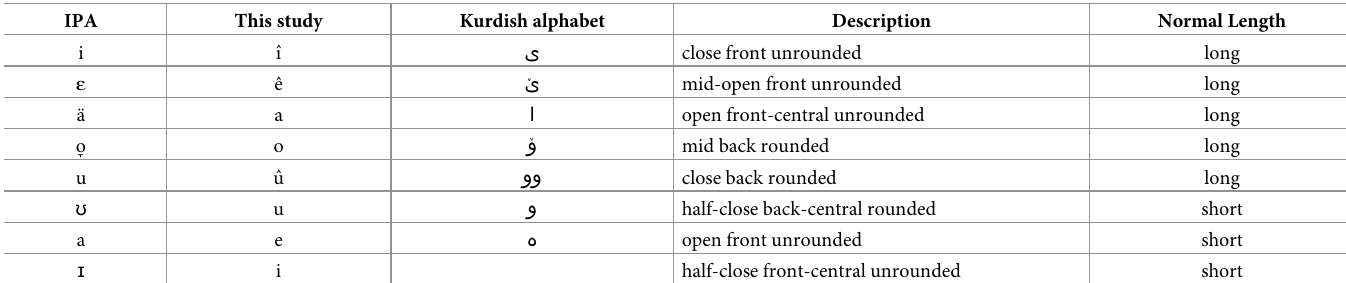
Table 2. Vowels of Standard Central